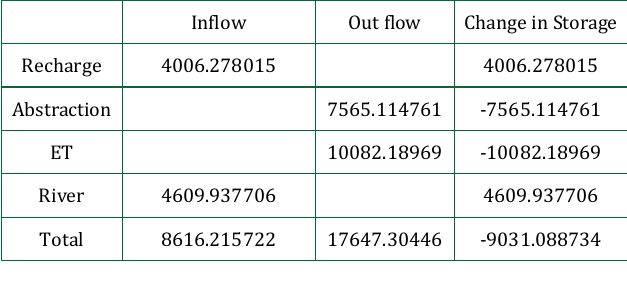
Table 7: Annual GW abstractions decreased 10% with increased the Canal Supply (MCM)